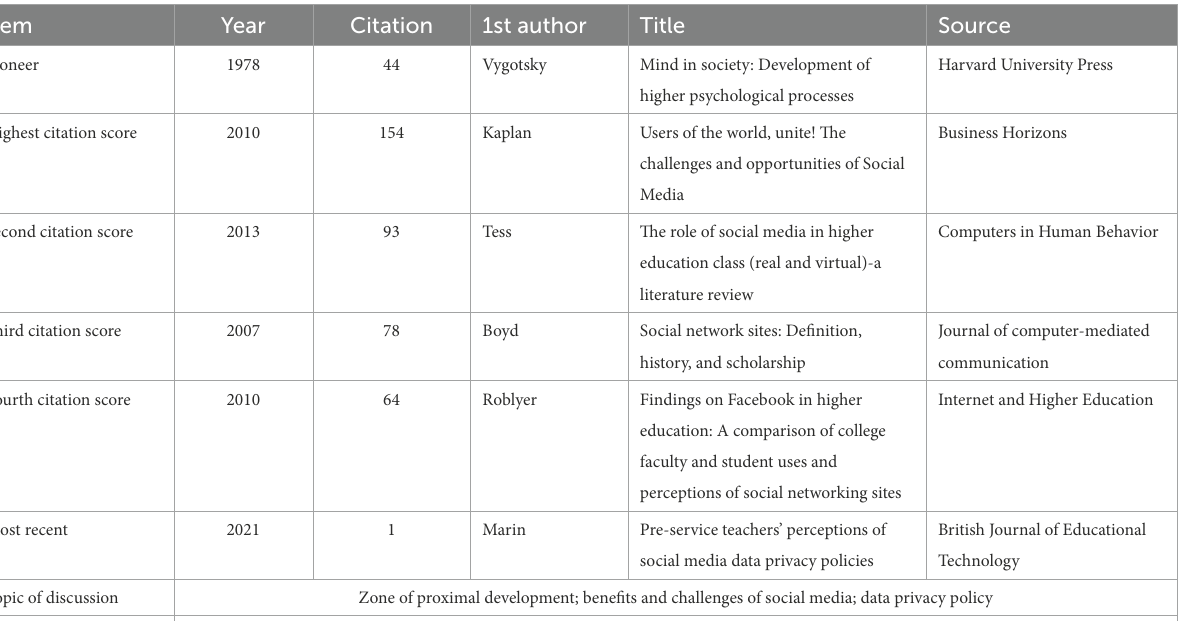
TABLE 2 Major findings via the first